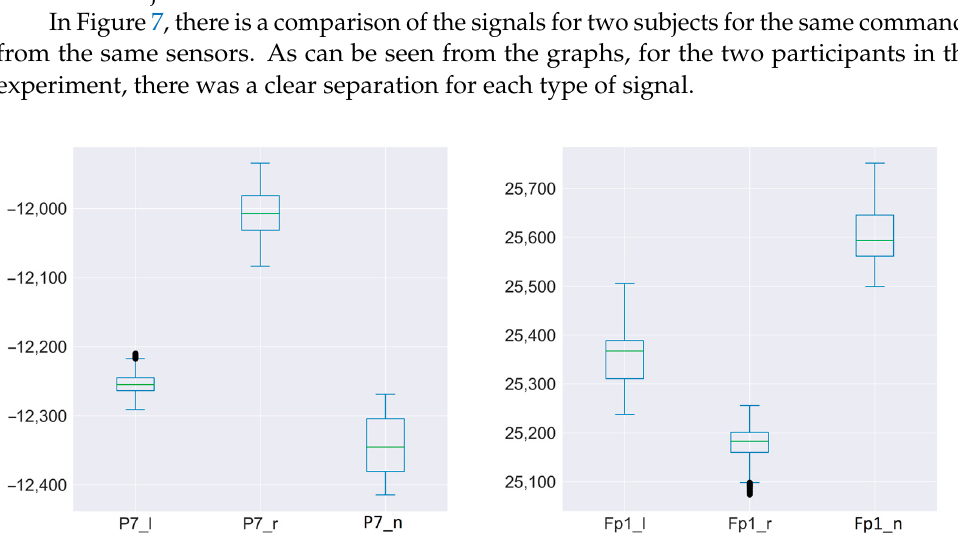
Figure 5. Changes in signals for one of the subjects for three states (rest, movement to the left, move- ment to the right) over time. Orange represents left hand, blue represents right hand, and green represents neutral state of